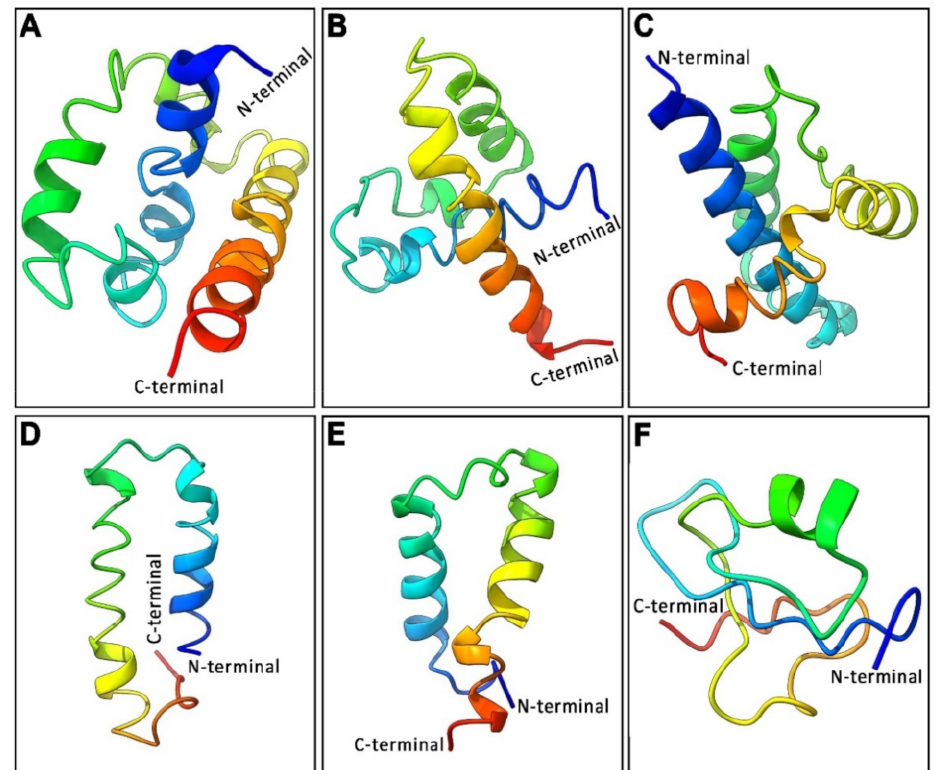
Figure 3. Predicted 3D structures of the three GnRH isoforms and corresponding three GnRH associated peptide (GAP) of small yellow croaker: ( A ) syc-GnRH1, ( B ) syc-GnRH2, ( C ) syc-GnRH3, ( D ) syc-GAP1, ( E ) syc-GAP2, and ( F ) syc-GAP3. The model was constructed using an I-TASSER online tool. Domains between the N-terminal and C-terminal were predicted from the secondary